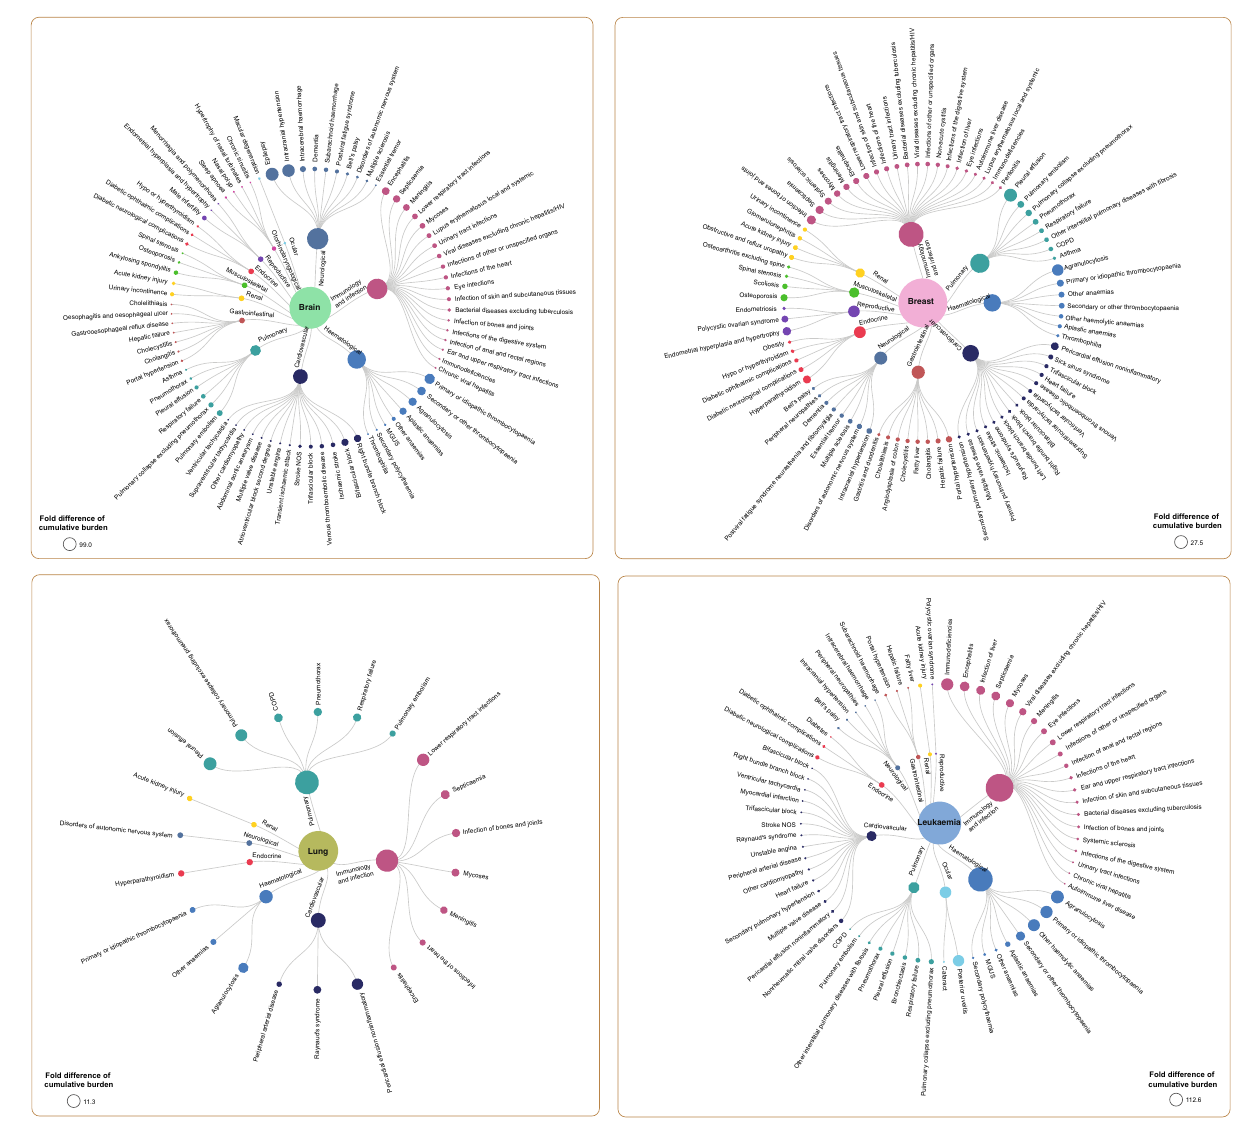
Fig. 2 | Cumulativeburdenofhealth conditionsamong cancersurvivors atage 60 across 26 cancer types. Circular dendrograms depict the fold difference of cumulative burden in survivors versus controls where conditions with a fold dif- ference of ≥ 2 are shown. Fold difference for health conditions in patients with leukaemia, brain, breast and lung cancers are shown. The area of the nodes is proportionaltothefolddifferenceofeachcondition,andtheconditionsareranked